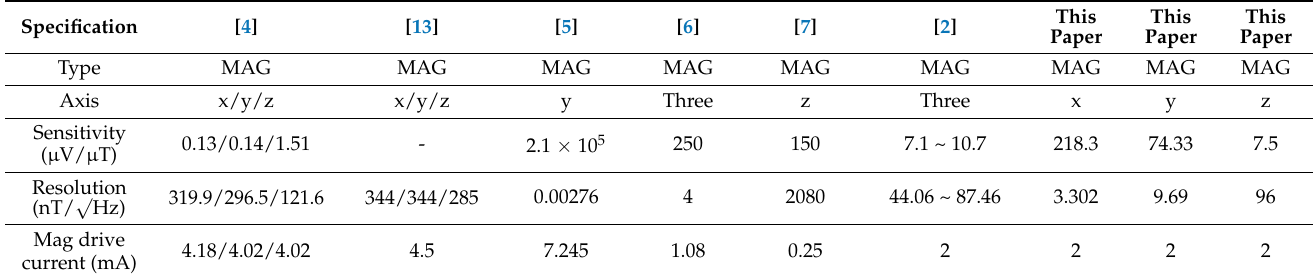
Table 4. Comparison of MEMS